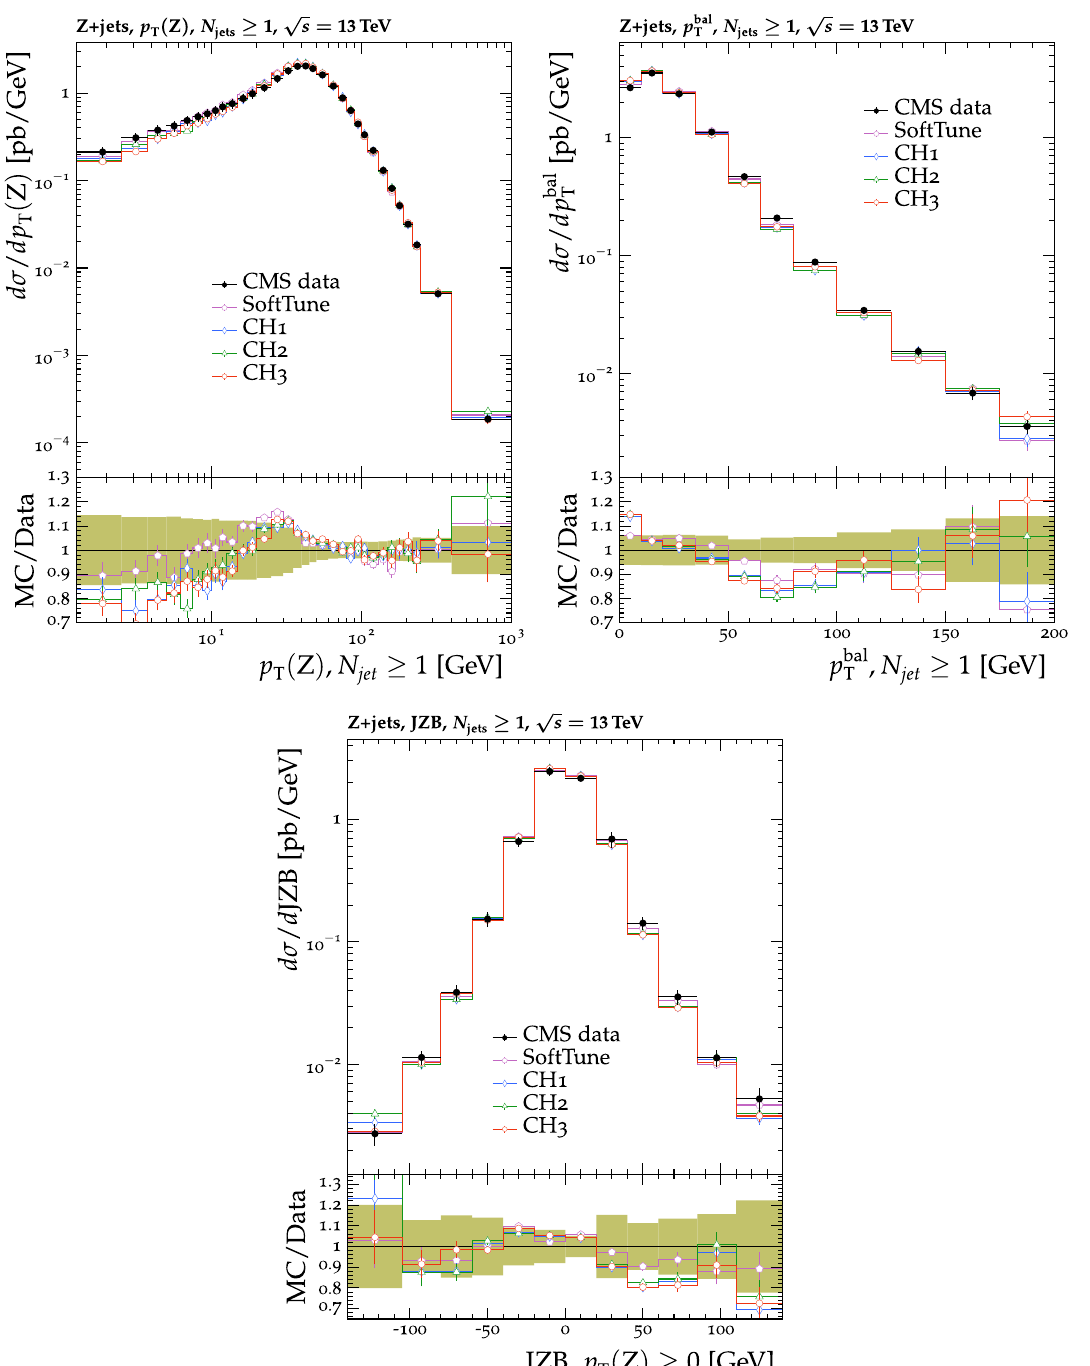
Fig. 19 Differential cross sections as a function of p T ( Z ) (upper left), p bal (upper right), and JZB (lower) [46]. CMS Zboson data are com- T pared with the predictions from MadGraph 5_a mc@nlo + herwig 7, with the SoftTune and CH tunes. The coloured band in the ratio plot